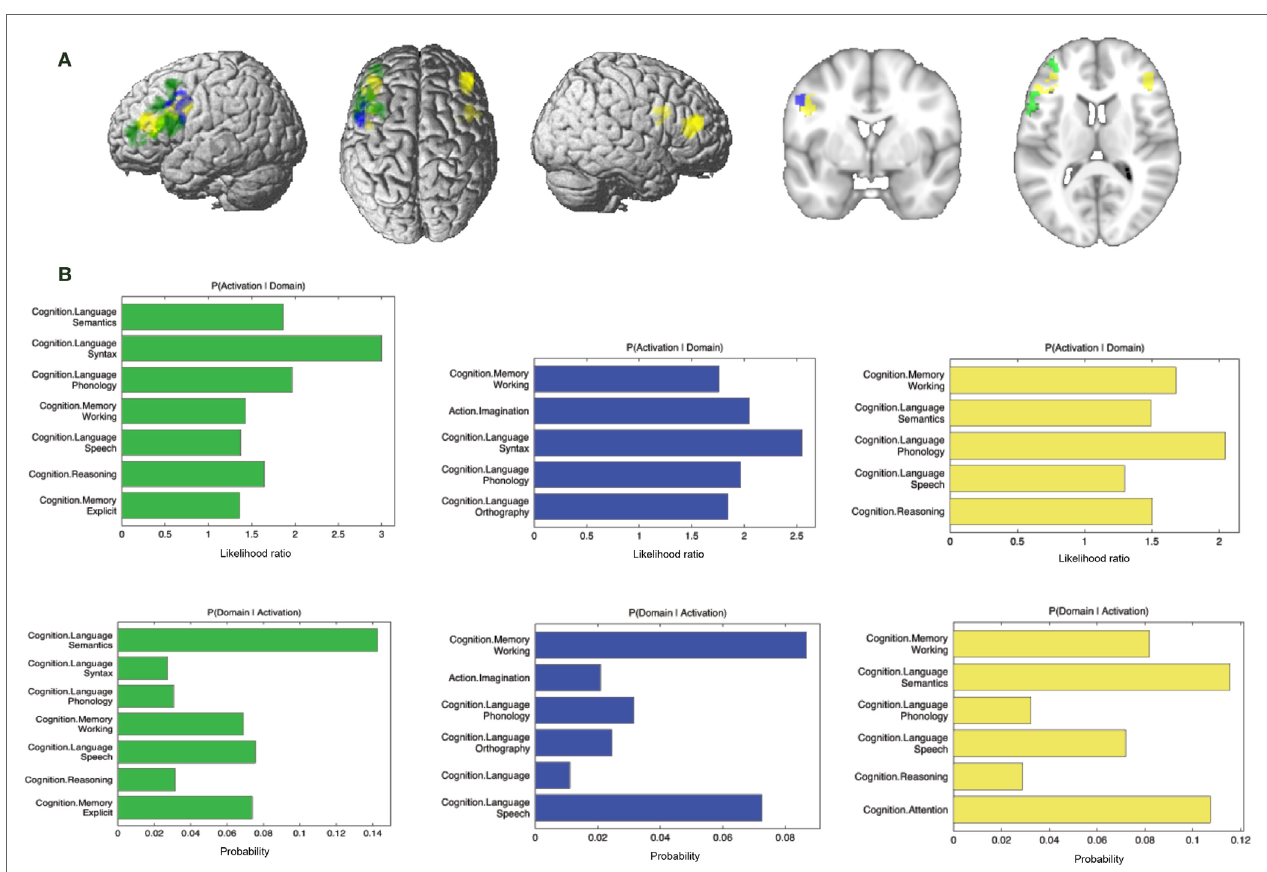
FigUre 8 | specifically missing connectivity of seed and functional characterization . (a) Specifically missing connectivity for MACM (green), SC (blue), and PT (yellow). An additional cluster extent threshold of 100 voxels was applied. (B) Behavioral domains from the BrainMap database significantly associated with the specifically missing regions shown in (a) (FDR-corrected for multiple comparisons, p < 0.05).